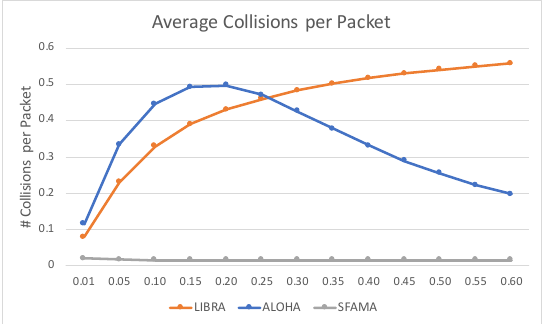
Figure 14. Average number of collisions per